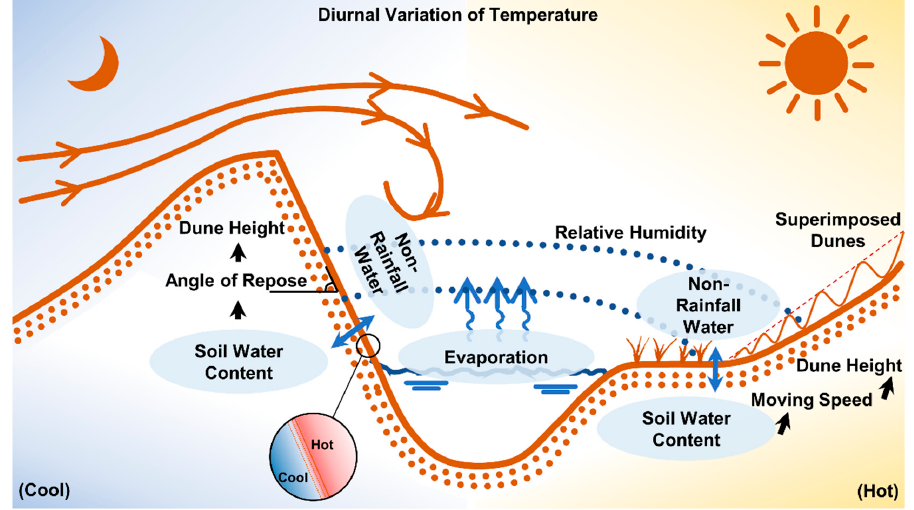
Figure 11. Schematic of the model of mega-dune growth with the lake-dune pattern. Finally, it is important to note that this is not the dominant, but only a contributing, factor in the formation of the mega-dunes in the Badain Jaran Sand Sea. As mentioned earlier, without the lakes, the dunes in the Badain Jaran Sand Sea could also grow to about 300 m in height.